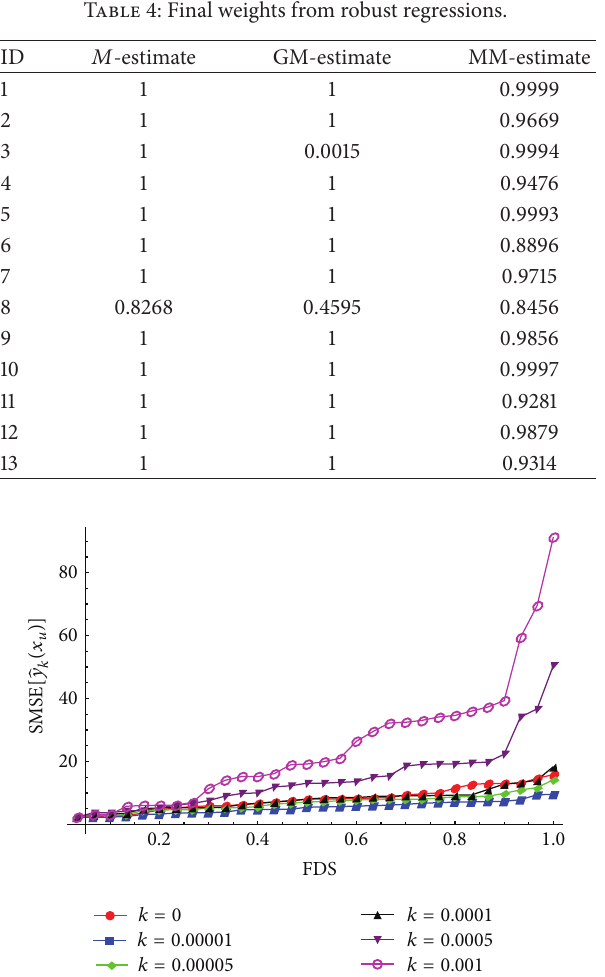
Figure 1: The FDS plots for different 𝑘 values according to the randomly generated mixture, where